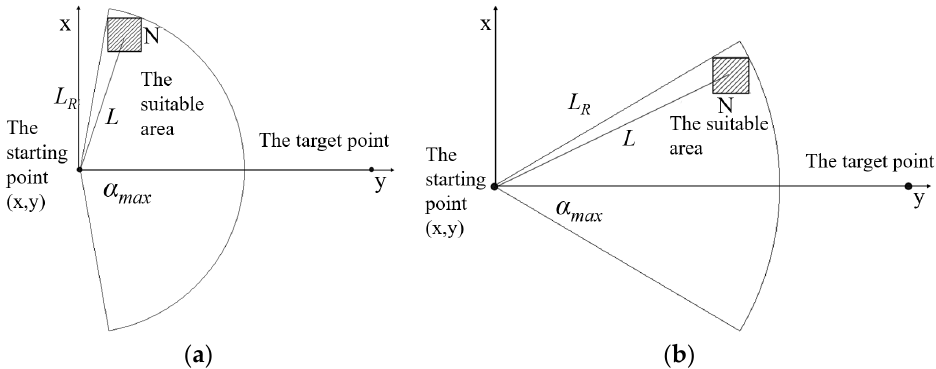
Figure 7. TAN-suitable area at edge using different central angles. ( a ) TAN-suitable area searching with a large central angle; ( b ) TAN-suitable area searching with a small central angle. To ensure that the movement distance of the vehicle along the line direction d x between the starting point and the target point is greater than that in the other direction d y (that is, d x ≥ d y ), it is necessary to calculate an appropriate value of α max , and the value of α max at condition d x = d y is shown in Figure